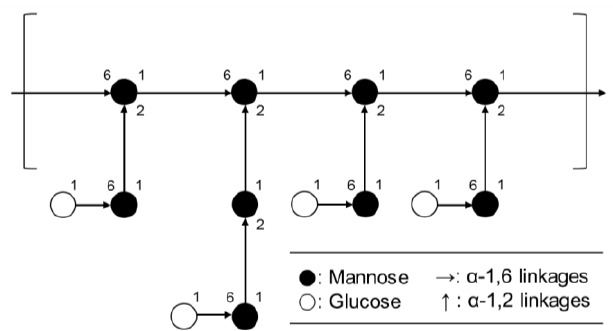
Figure 4. Major glycosyl types of EPS from L. paracasei EPS DA-BACS identified by mass spectra of PMAAs. Myo -inositol was the internal standard.